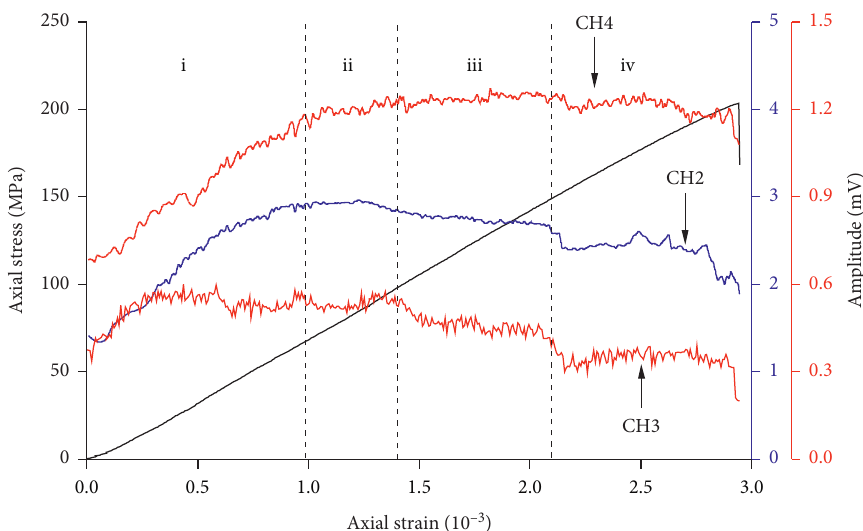
Figure 7: Amplitude of the first arrived wave of granite at three locations under uniaxial